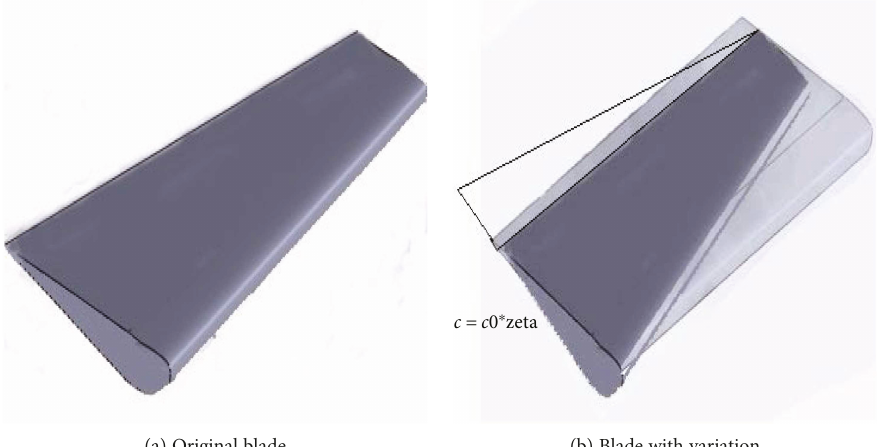
Figure 4: Illustration of variation in blade root